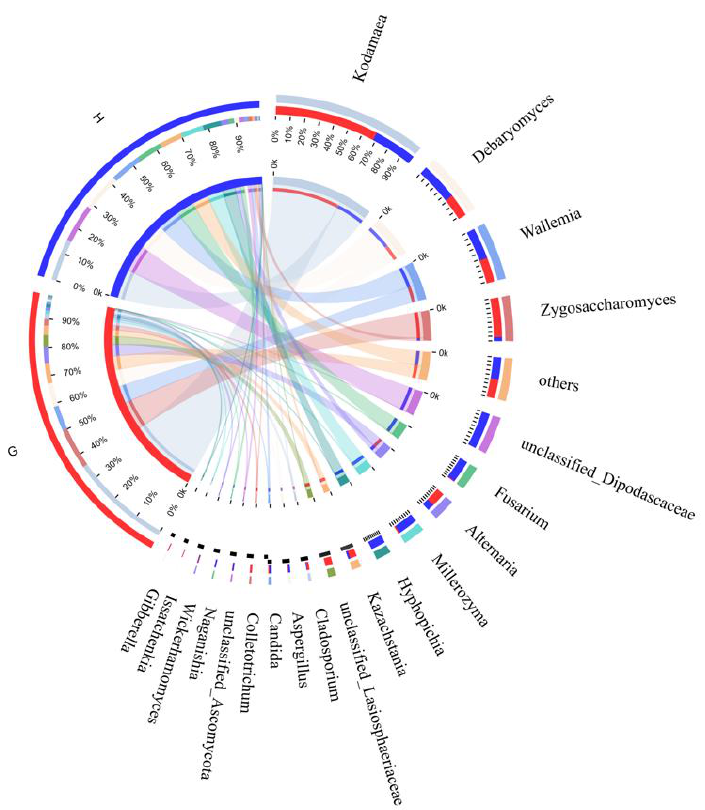
Figure 4. Circos diagram of fungi at the genus level in the Suanyu samples. G: The group of Suanyu samples from Guizhou; H: the group of Suanyu samples from Hunan.